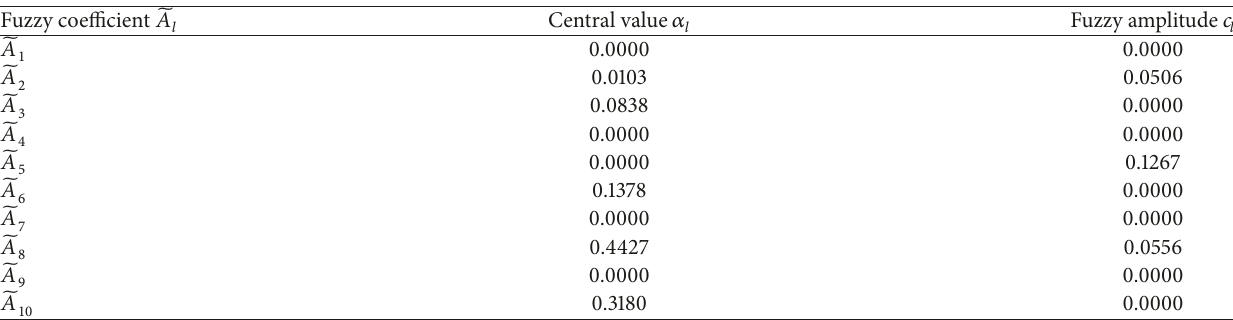
Figure 2: Clustering result curves based on common validity indices. Table 1: Fuzzy